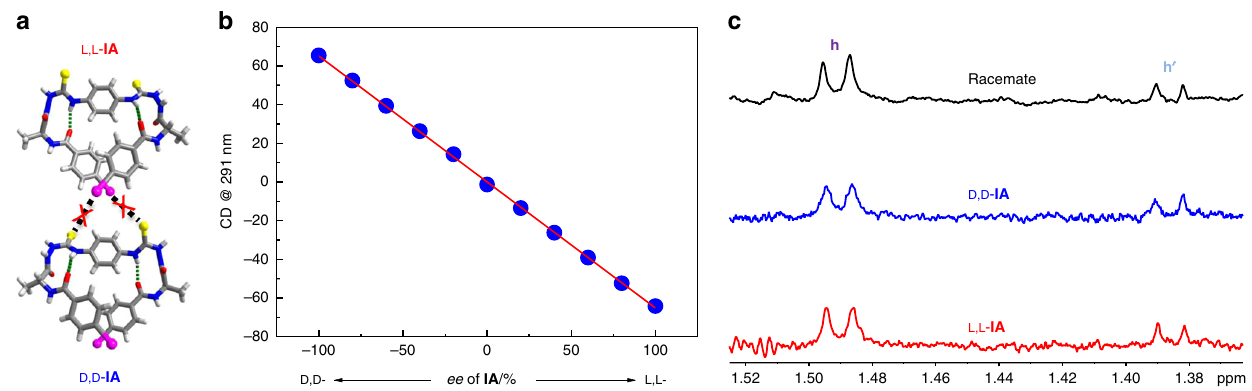
Fig. 5 Study of homochiral self-sorting. a Illustration that the crossed C − I···S halogen bonds between one L,L- IA and one D,D- IA molecules are unlikely because of the mismatched orientation of I-atom and S-atom. b Plots of CD signal at 291 nm of IA in CH 3 CN against ee . [L,L- IA ] + [D,D- IA ] = 5 μ M. c Partial 850 MHz 1 H NMR spectra of – CH 3h in L,L- IA , D,D- IA and their racemate in CD 3 CN at 25 °C. The solutions were sample